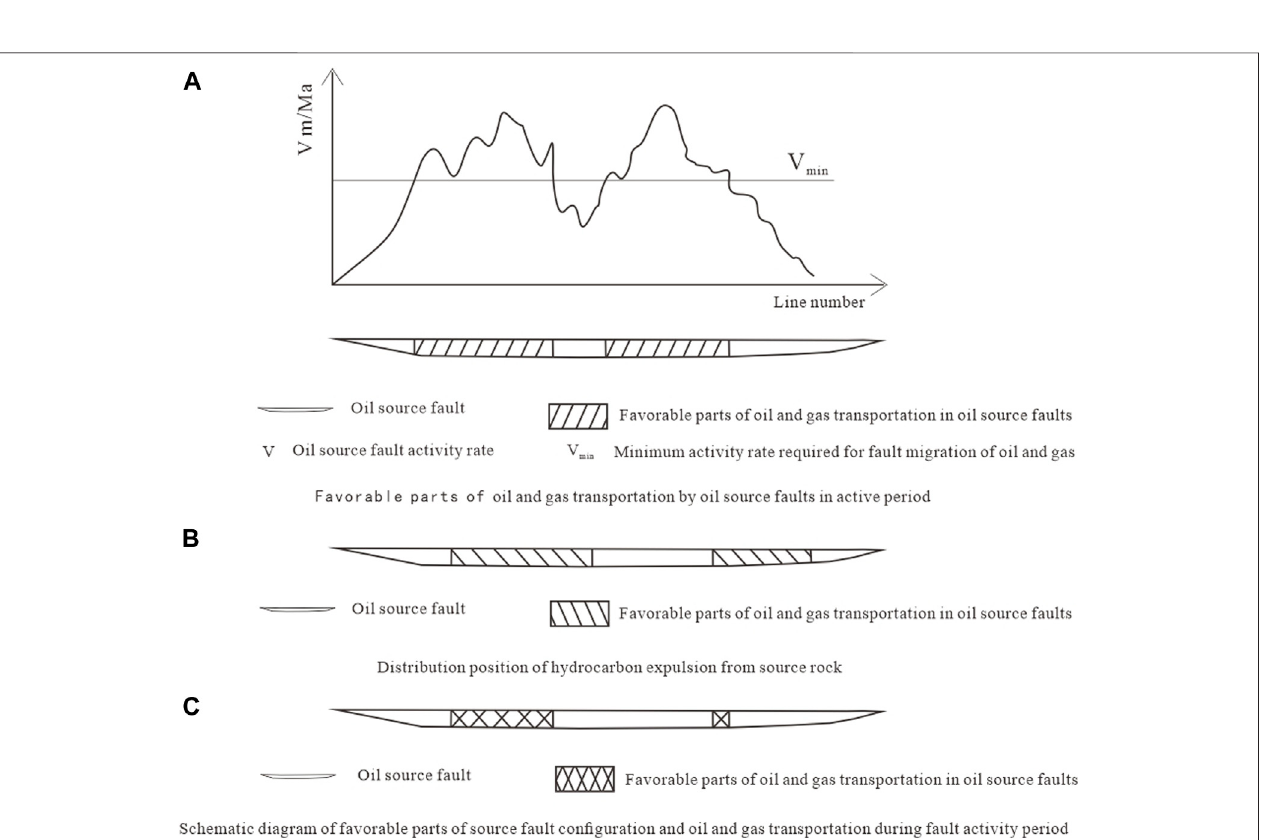
Frontiers in Earth Science |